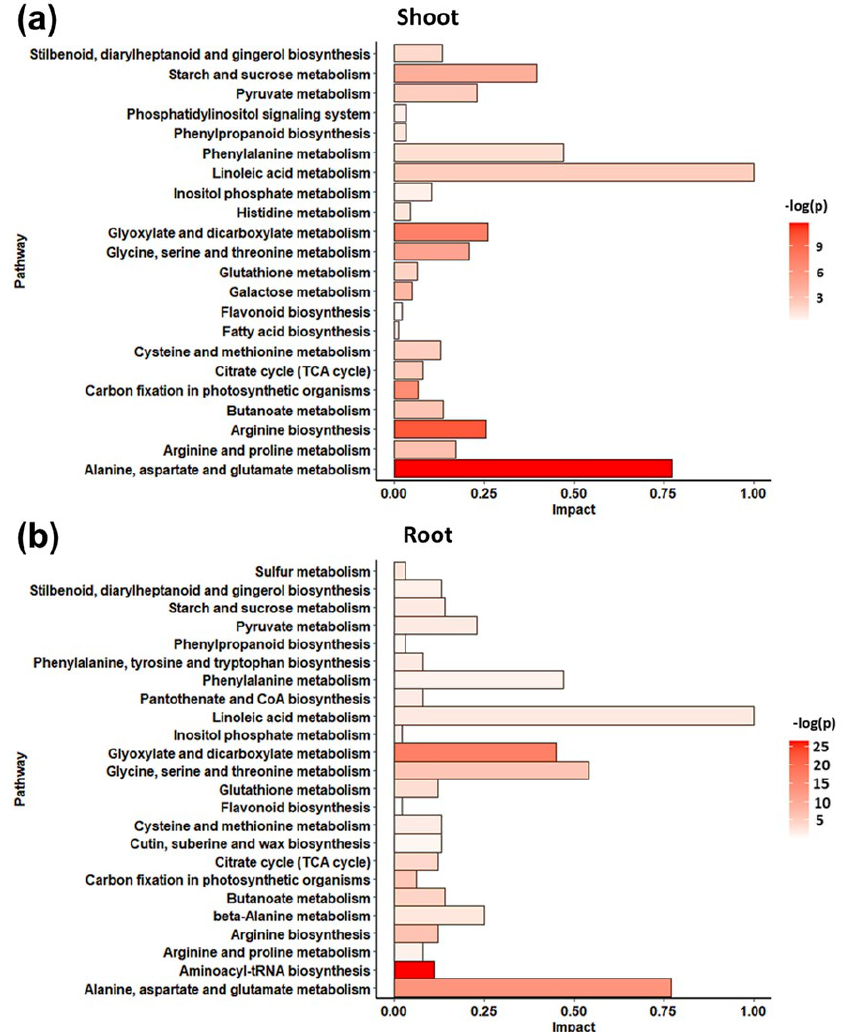
Figure 2. Enrichment pathway analysis. Metabolite pathways enrichment analysis of highly accu- mulated metabolites in ( a ) shoots and ( b ) roots from plants treated with affinin at 100 µM ( n = 3).